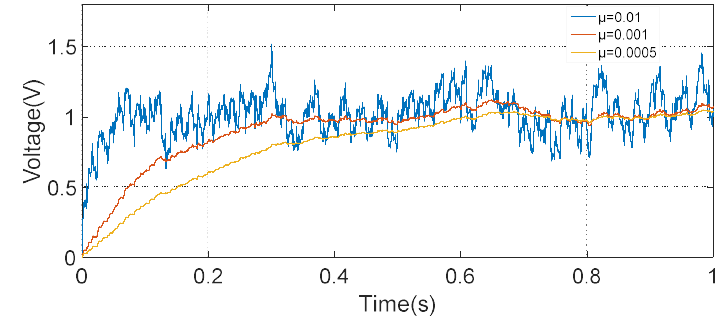
Figure 14. Curve of the demodulation signal amplitude.